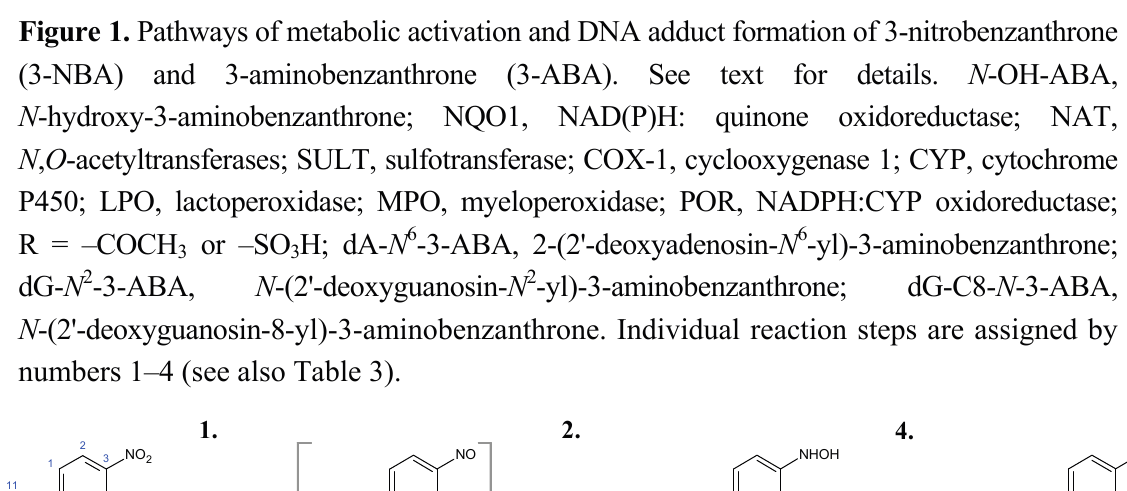
N-OH-ABA 3-ABA 3a. NH + + 3-NBA-derived DNA adducts + DNA (e.g. dA-N 6 -3-ABA,